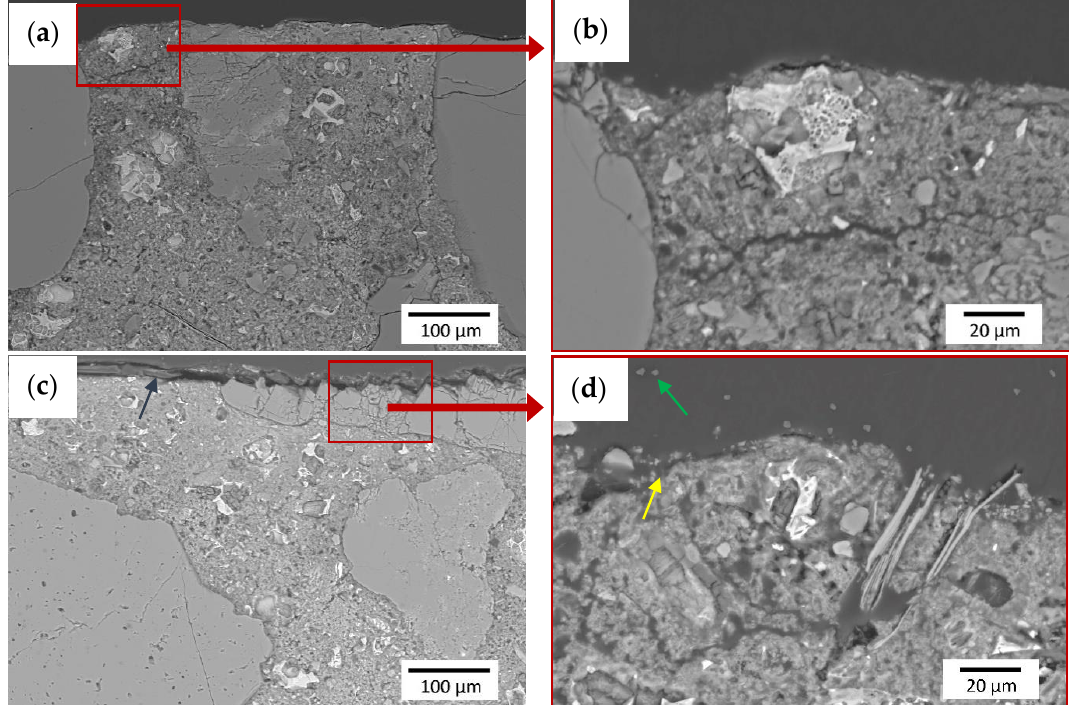
Figure 16. Microstructure of the interphase between the epoxy resin and substrate: ( a , b ) unmodified sample, ( c , d ) sample modified with 0.5 wt % of polypropylene fibers. The test was conducted using SEM and the BSE detector (yellow arrow—resin-filled pores on the surface of the sample, green arrow—cross-section of polypropylene fibers).